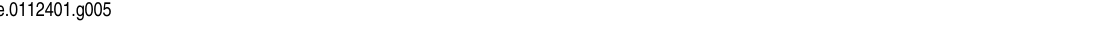
Fig. 5. Changes over time in the hardness (A) and friability (B) of tablets stored at 25 ˚ C/60% RH in comparison with T0. The vertical bars represent the 95% confidence interval limits for the measured hardness (A) and friability (B)